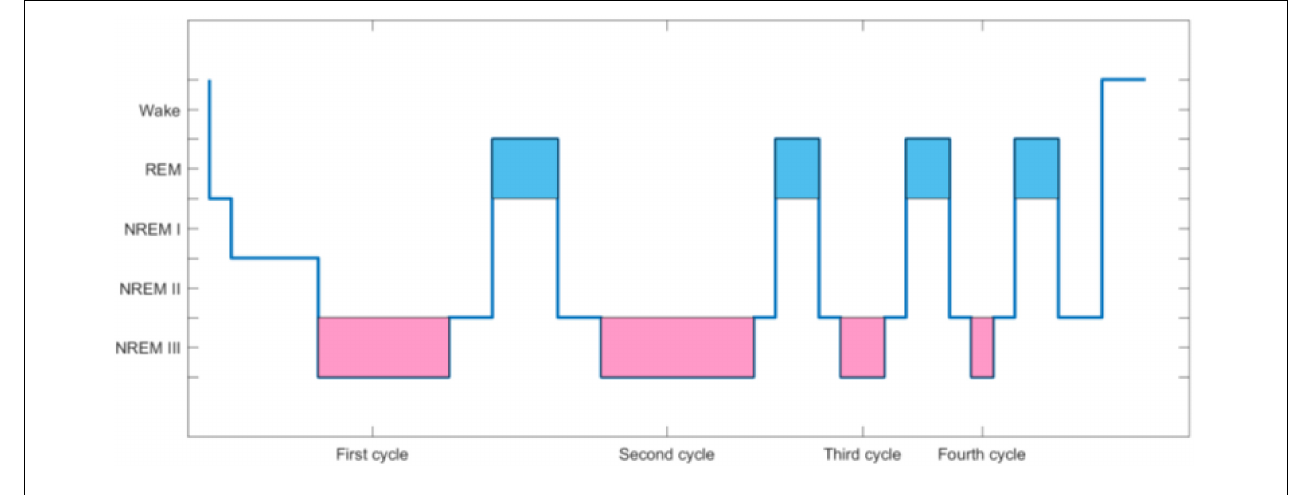
FIGURE 1 | Adult sleep structure